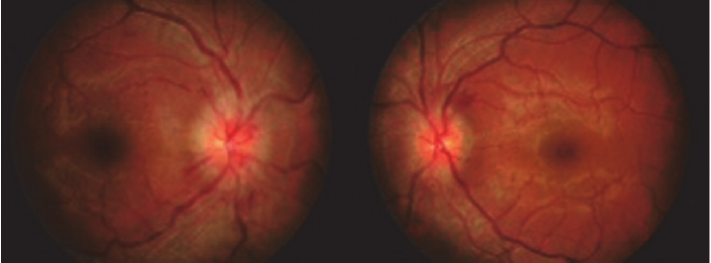
Figure 1: Fundus photo on presentation showing bilateral generalised optic disc swelling with splinter haemorrhages.